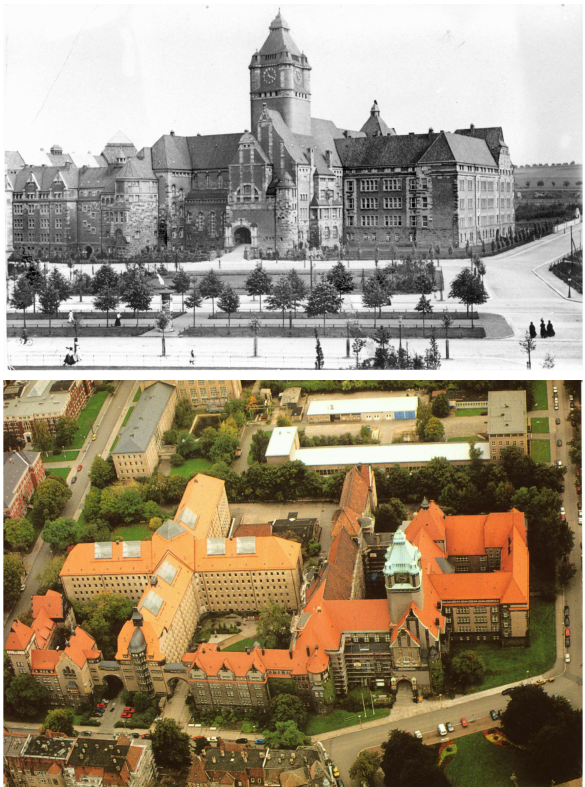
Figure 4. Both images for which the pose could not be estimated in an automatic workflow.